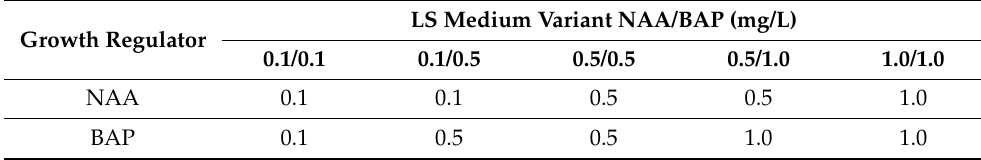
Table 5. Concentration of plant growth regulator [mg/L] in LS medium variants. Growth